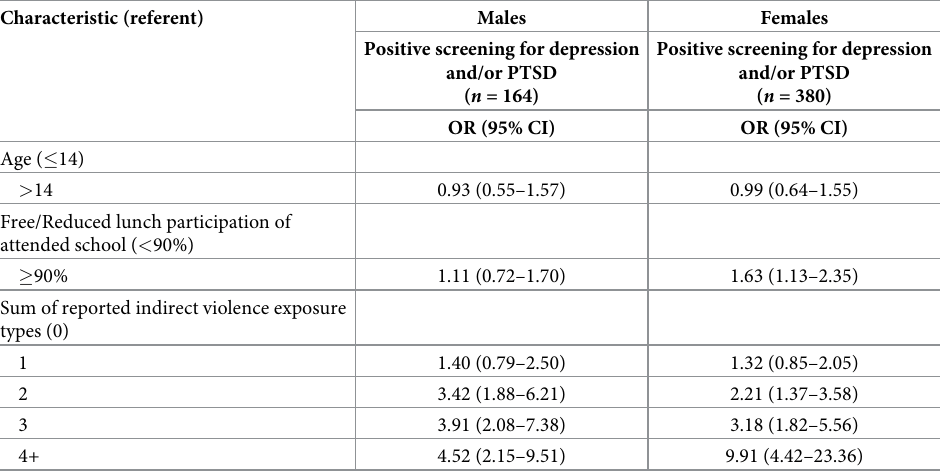
Table 9. Multivariate logistic regression models for any MH Outcome, by gender (N =